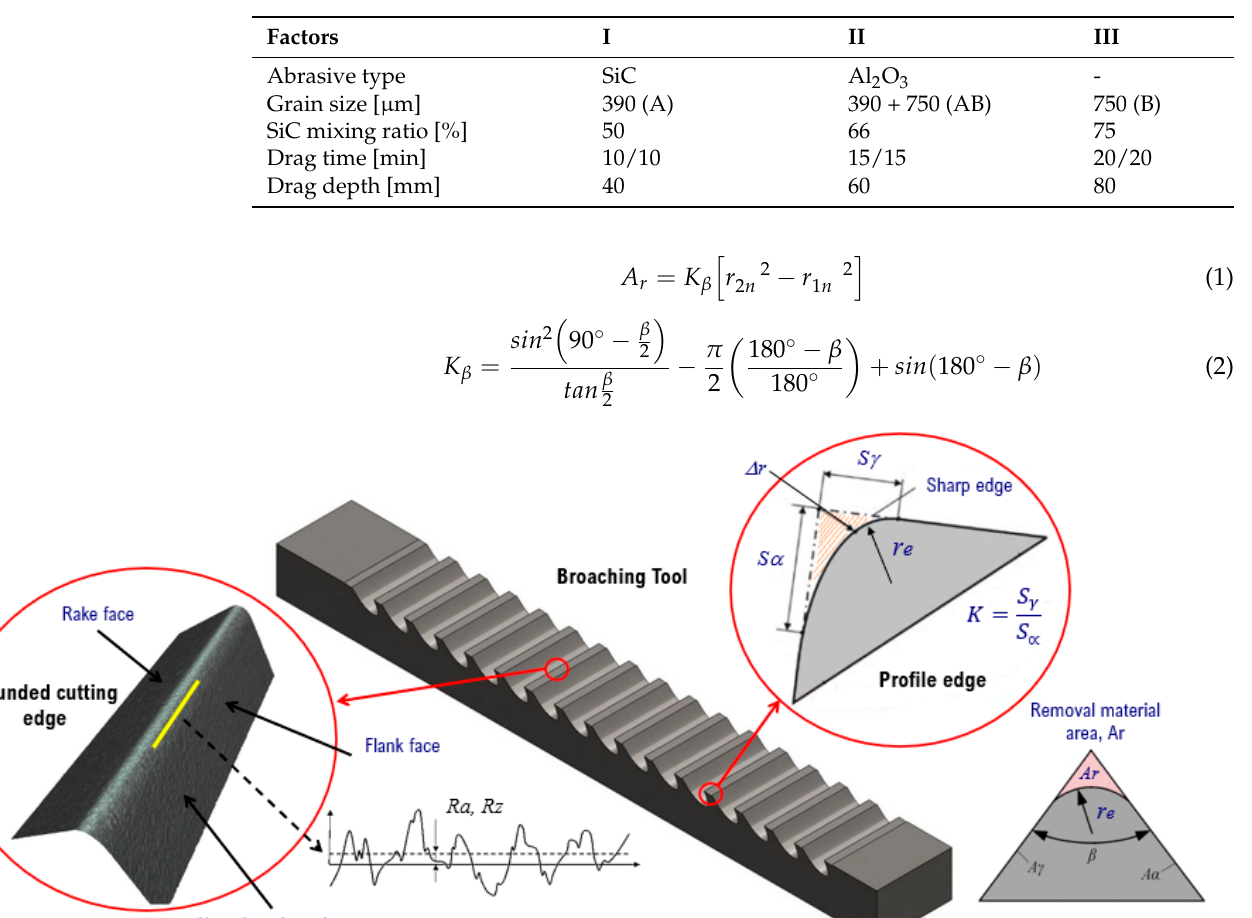
Table 1. Factors levels for experimental application.